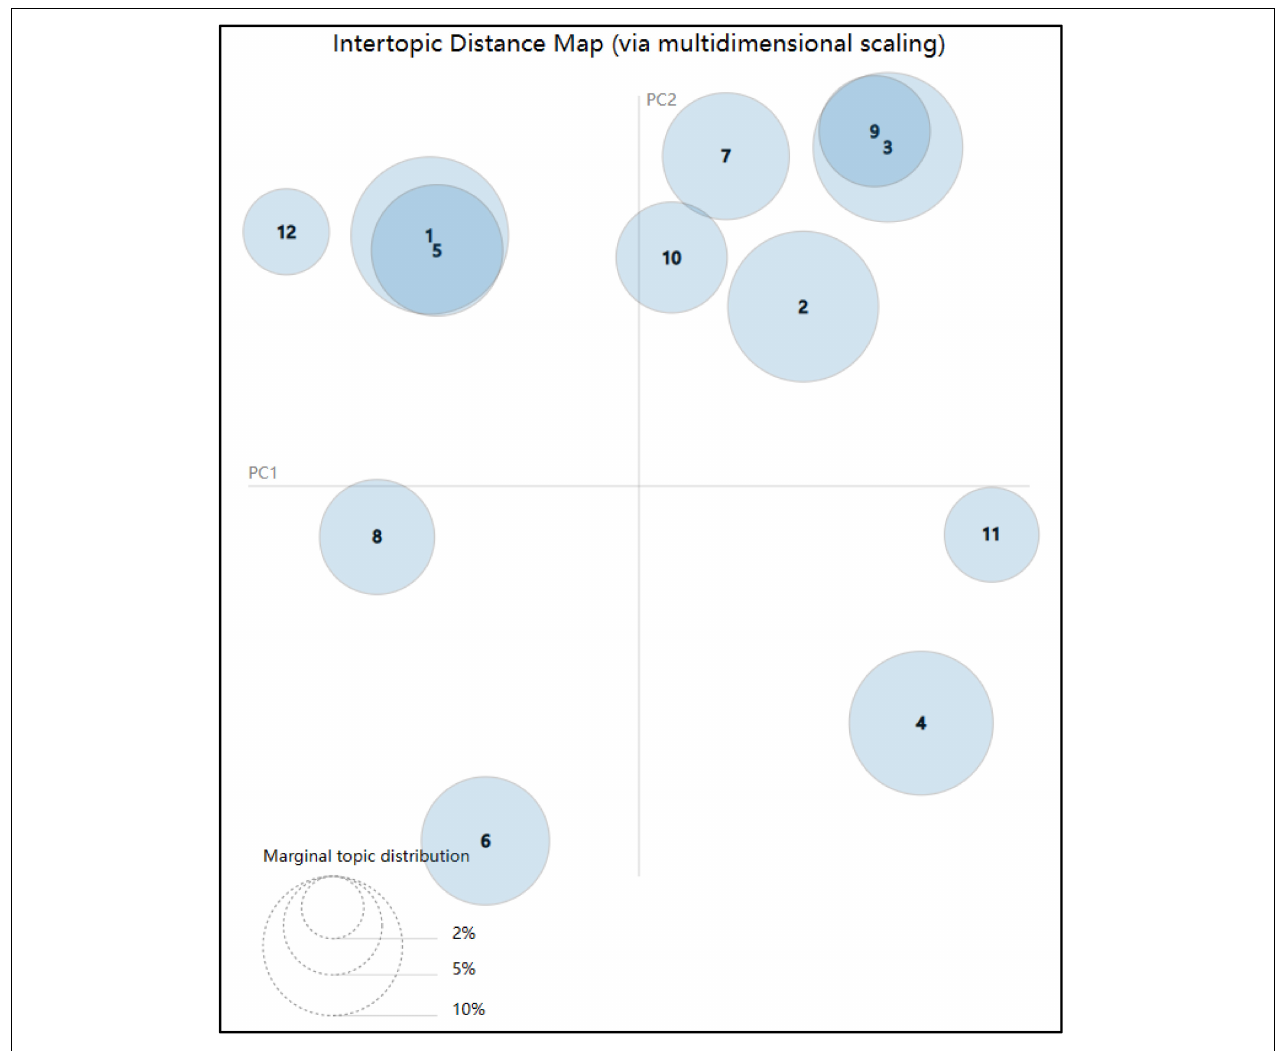
FIGURE 3 | Topic visualization.